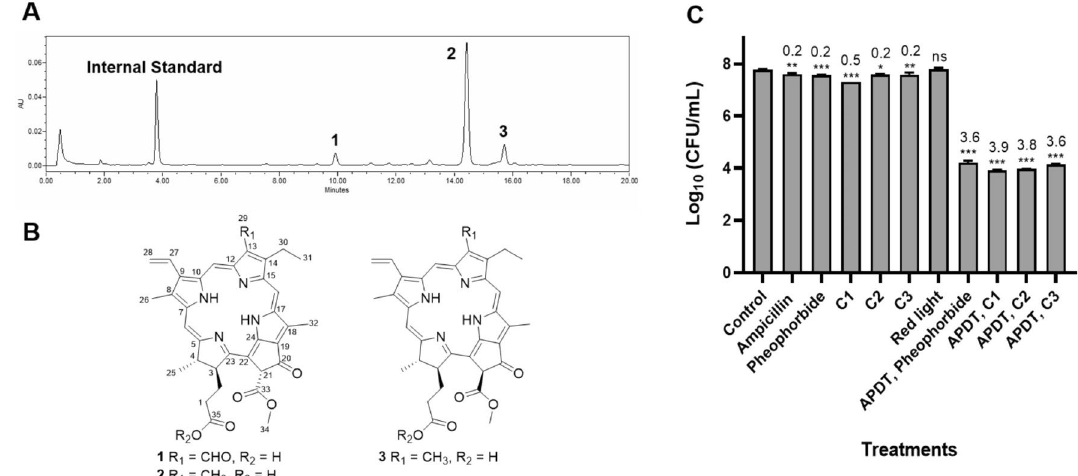
Fig. 4 Chemical profiling of LFE. A UPLC–PDA chromatogram of LFE. B The chemical structures of isolated compounds 1 activities against S. aureus KCTC3881 of isolated compounds C1–C3. APDT with isolated compounds (10 µg/mL; incubation time, 30 min) against S. aureus under red light (20 W/m 2 ; 30 min). Ampicillin (100 µg/mL) and APDT with pheophorbide were used as positive controls. The data are expressed as mean standard error (n 2) and representative of three independences. ns indicates no statistical significance relative to the control ± = group. Significant differences are expressed with * for p < 0.05, ** for p < 0.01, and *** for p < 0.001 relative to the vehicle control. The log reductions compared with vehicle control are presented in each